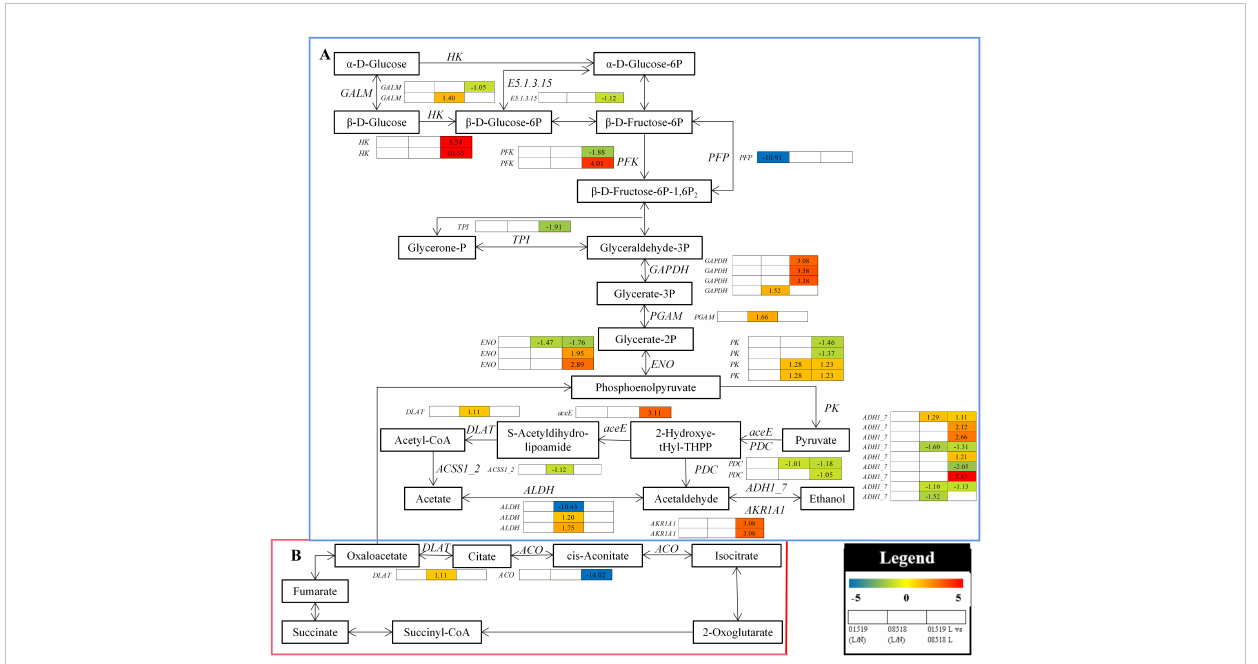
FIGURE 7 Analysis of the carbohydrate metabolism pathway in plants under low-P stress. (A) Glycolysis/gluconeogenesis. (B) Citrate cycle. Log 2 (fold-changes) of the comparisons are shown by the numbers in the gray rectangles. The comparisons show that each of the genes in the picture is signi fi cantly differentially